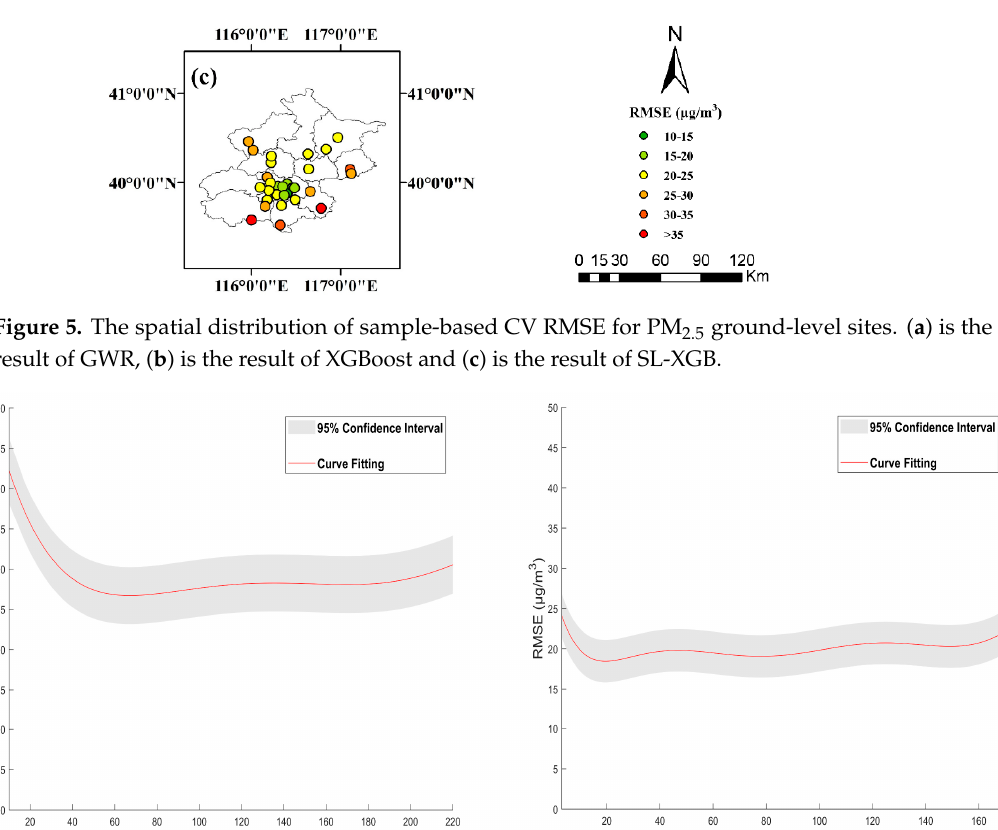
Figure 6. The relationship between bandwidth distance and RMSE. The left is the result of suburban sites and the right is the result of urban sites. The red lines are the polynomial fitting curves and the shadow areas represent the 95% confidence interval.